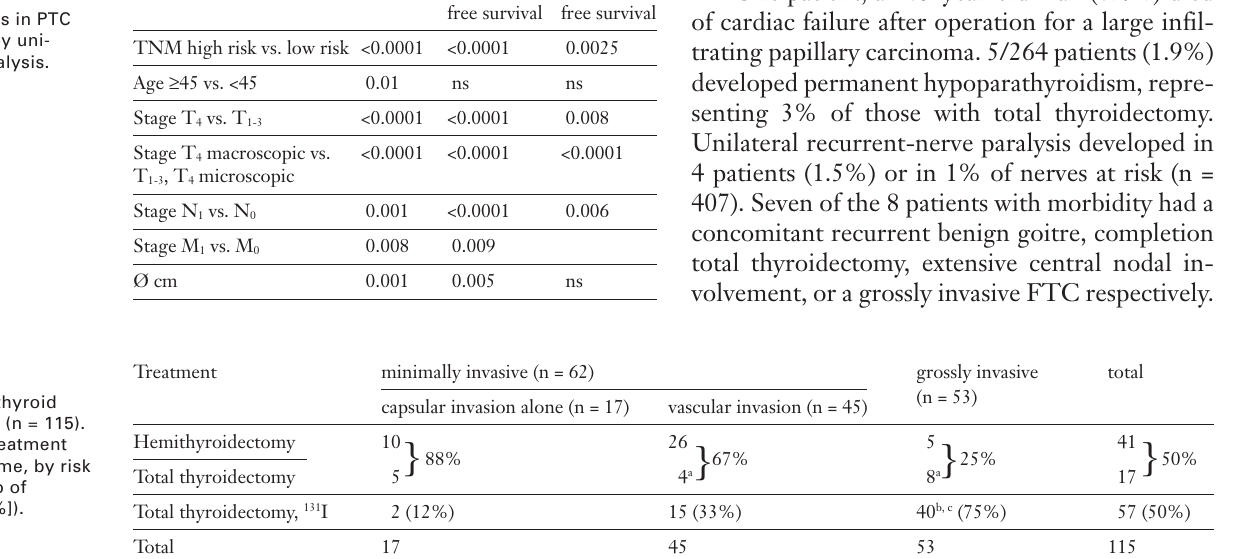
Risk factors in PTC (n = 146) by uni- variate analysis.